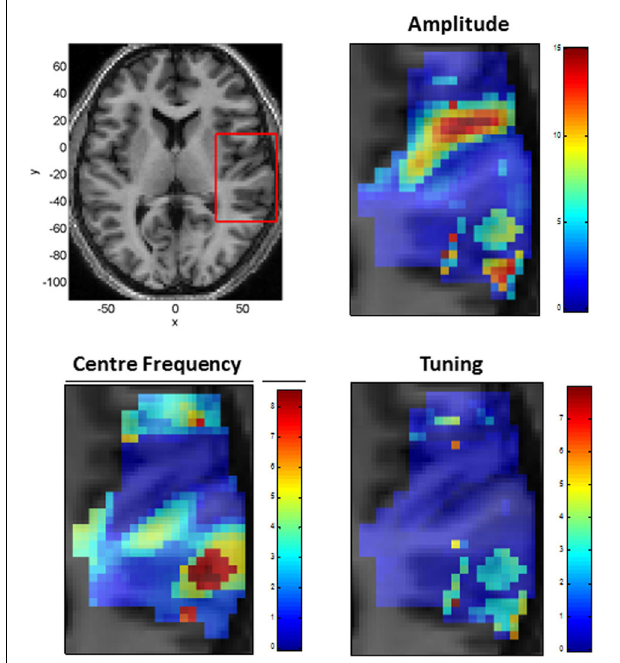
FIGURE 7 | Tonotopic Mapping with Mexican-Hat neural response functions. Top Left: Axial slice of structural image at z = 6 with bounding box showing region displayed on other three panels (x, y, and z denote MNI coordinates in mm), Top Right: Amplitude β (arbitrary units). Bottom Left: Center Frequency μ (kHz). Bottom Right: Tuning, W (ratio of Center Frequency to